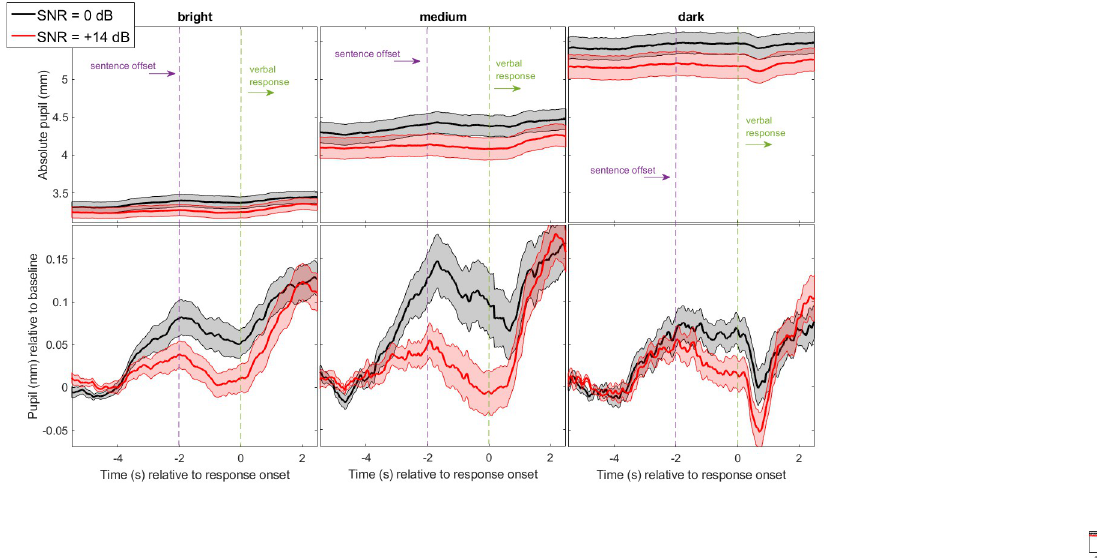
Fig 3. Pupil responses in Experiment 2. Mean pupil traces recorded for 28 listeners in Experiment 2: a sentence intelligibility task at two difficulty levels (0 and +14 dB SNR) under three luminance settings (dark, medium, and bright). Traces are all aligned by the onset of verbal response, and expressed in absolute units (top panels) to illustrate the massive light-evoked differences in pupil’s diameter, or corrected by their 1-sec baseline (bottom panels) to emphasize the peak pupil dilation. Shaded width represents 1 standard error from the mean.